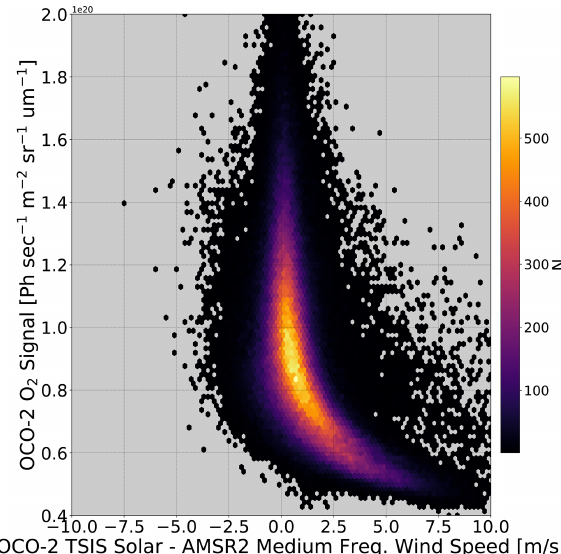
Figure 4. Heatmap of OCO-2 three-band Cox–Munk-only wind speed compared to AMSR2 medium-frequency wind speed. The B9 lite file quality flag and height scaling have been applied. The TSIS solar continuum is used. N is the number of retrievals, R is the cor- relation coefficient, RMSD is the root mean square deviation of the two datasets, σ is the standard deviation between the two datasets, (cid:49) is the mean difference, the dashed line is a one-to-one line, and y is a linear fit plotted as a solid line.